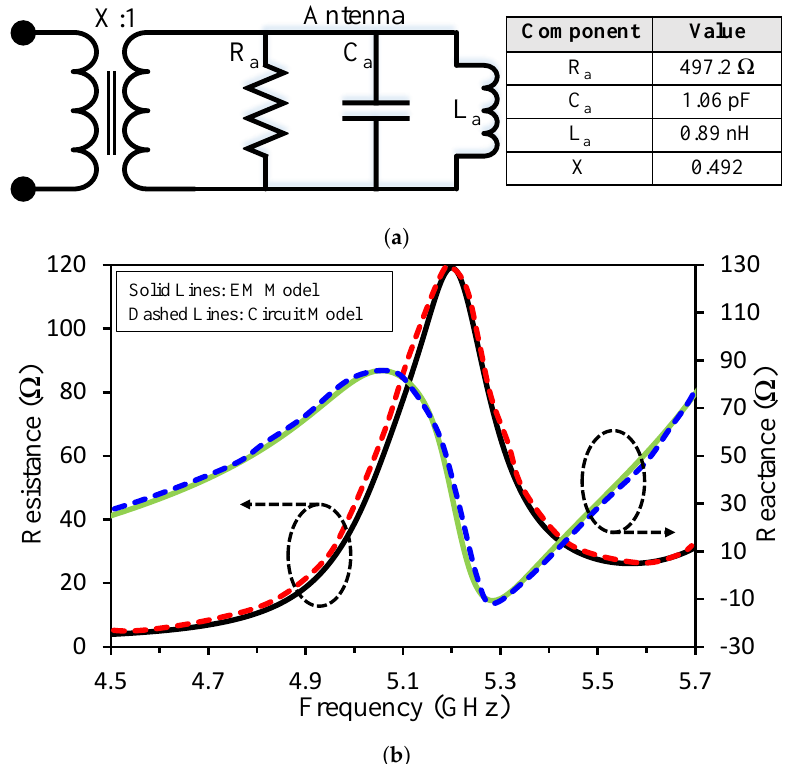
Figure 3. ( a ) Equivalent circuit model of the single-unit antenna, and ( b ) input impedance (resistance and reactance) comparison of the EM model (solid lines) and circuit model (dashed